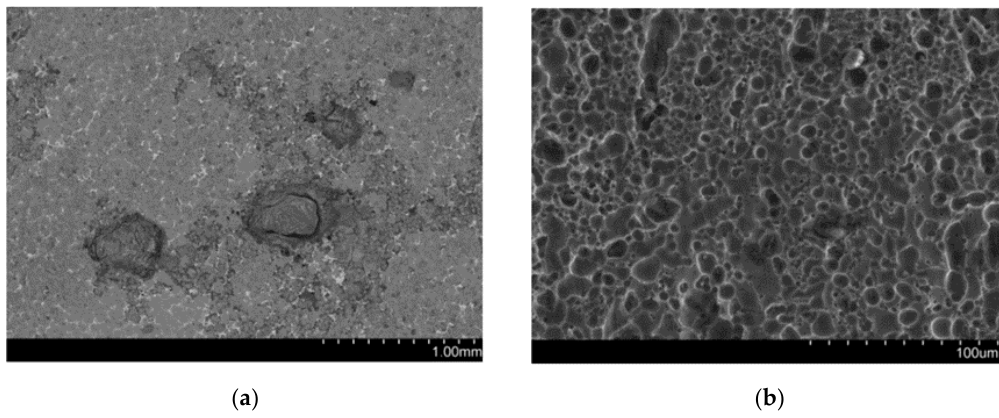
Figure 7. SEM images of pitting corrosion of WE43 in ( a ) as-cast and ( b ) T5 condition after immersion test.